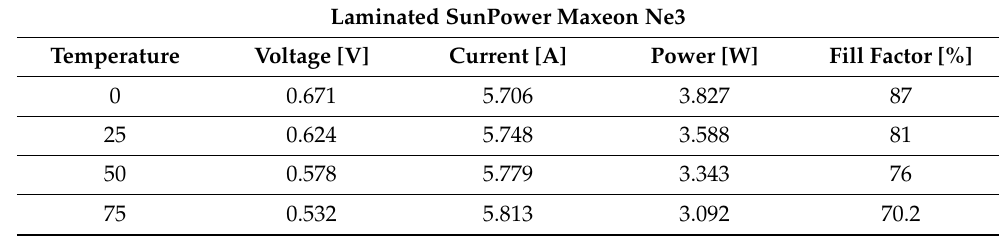
Table 6. MPPT data for tested solar cell in different temperatures.